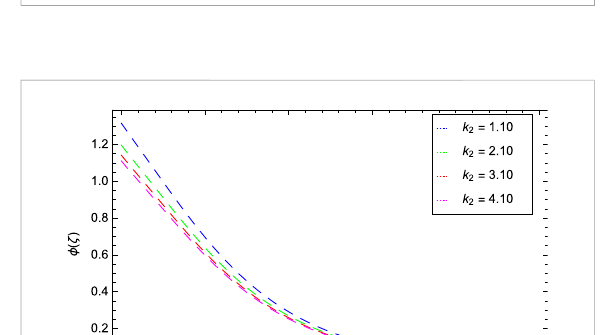
FIGURE 13 Role of the chemical reaction concentration pro fi le and parameter.